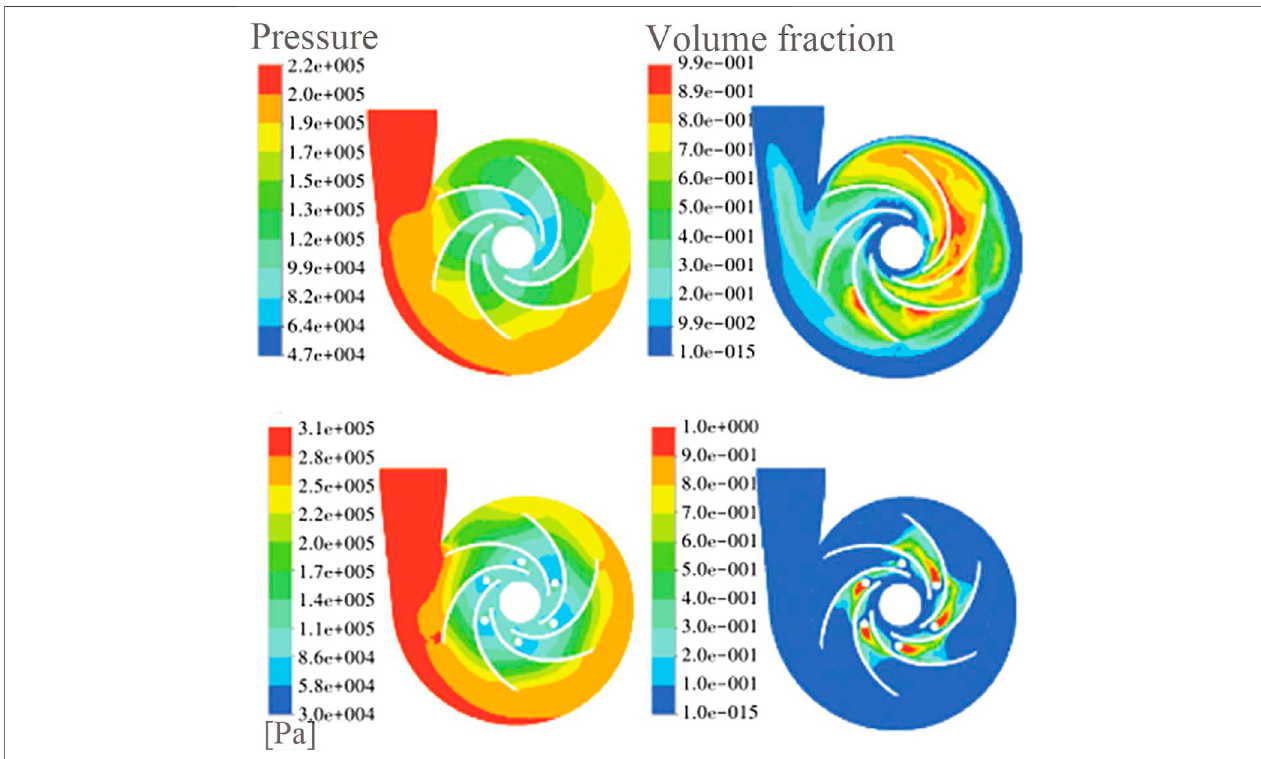
FIGURE 6 | Axial fl ow fi eld distribution of the high-speed centrifugal pump with different balance hole-speci fi c areas (Xiaorui Cheng, 2020).